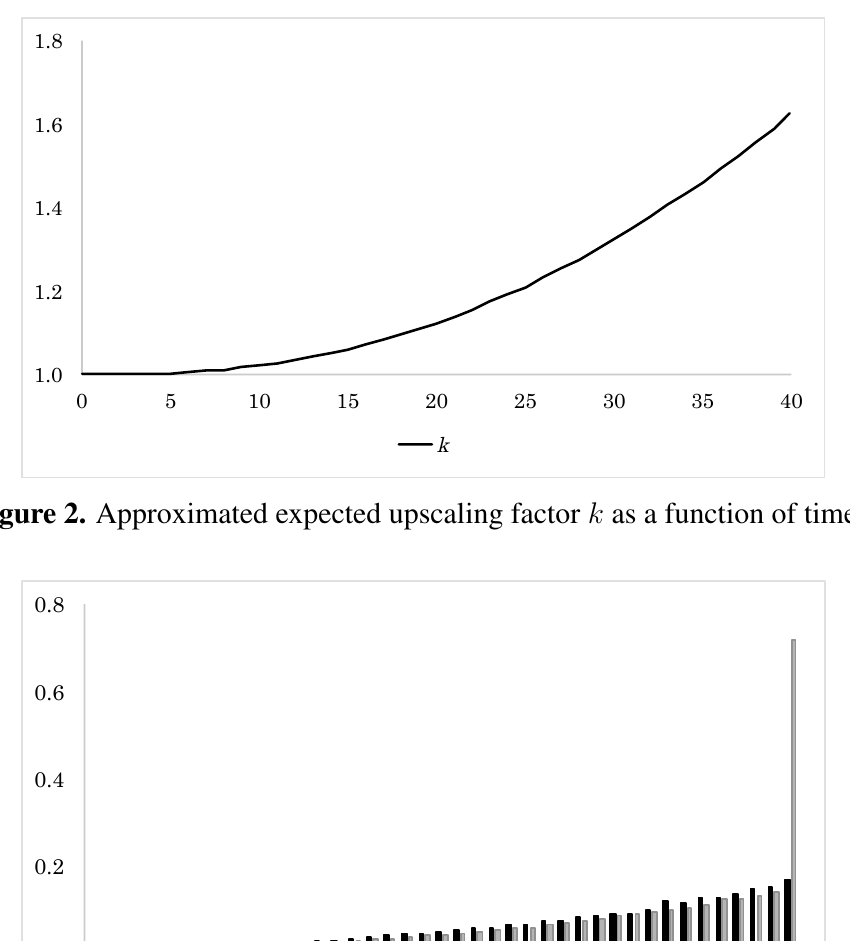
as a function g